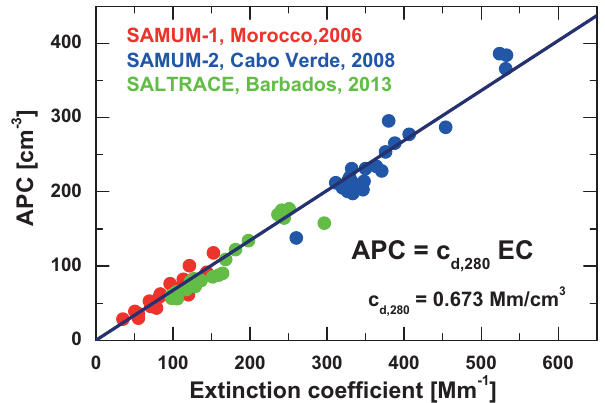
Figure 4. Relationship between dust layer mean 500nm ex- tinction coefficient (EC) and dust layer mean APC 280 for ob- servations taken during three desert dust field campaigns at Morocco, Cabo Verde, and Barbados. The linear regression yields c d,280 =0.673 ± 0.07Mmcm − 3 . The correlation coefficient is 0.915. c d,280 is used in Eq.